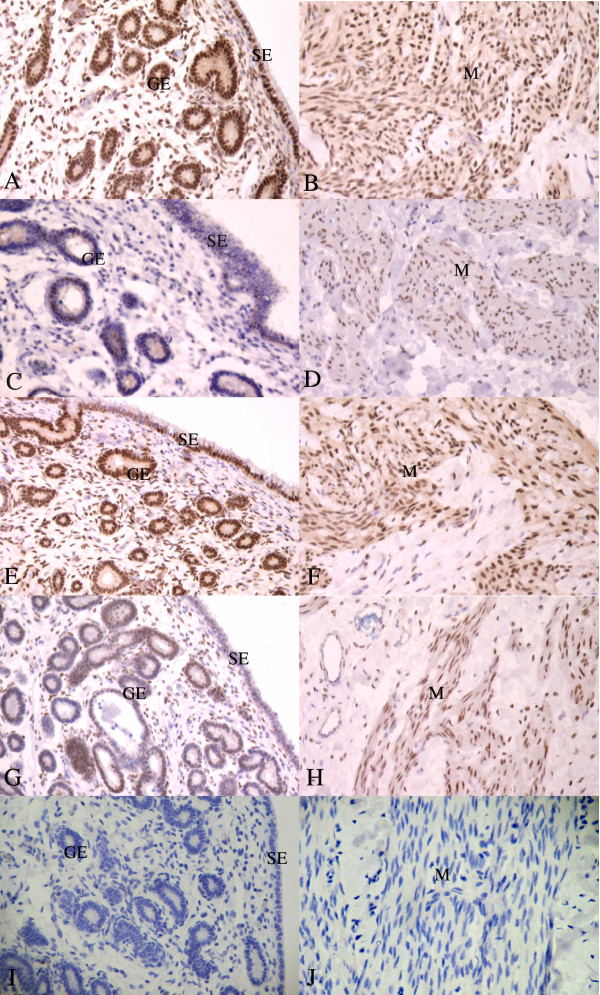
Immunostaining for ERα and PR in uterine tissue. A and B: ERα in mare 526 (intact in oestrus); C and D: ERα in mare 478 (intact in metoestrus); E and F: PR in mare 526 (intact in oestrus); G and H: PR in mare 478 (intact in metoestrus); I and J: negative control. SE = surface epithelium; GE = glandular epithelium; M = myometrium. Magnification 200×.